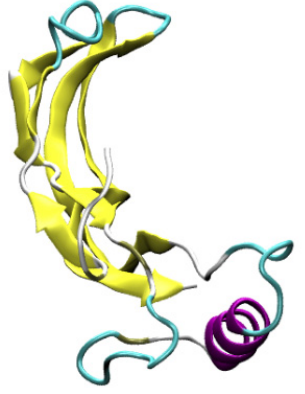
Figure 1. Initial BMP-2 configuration.